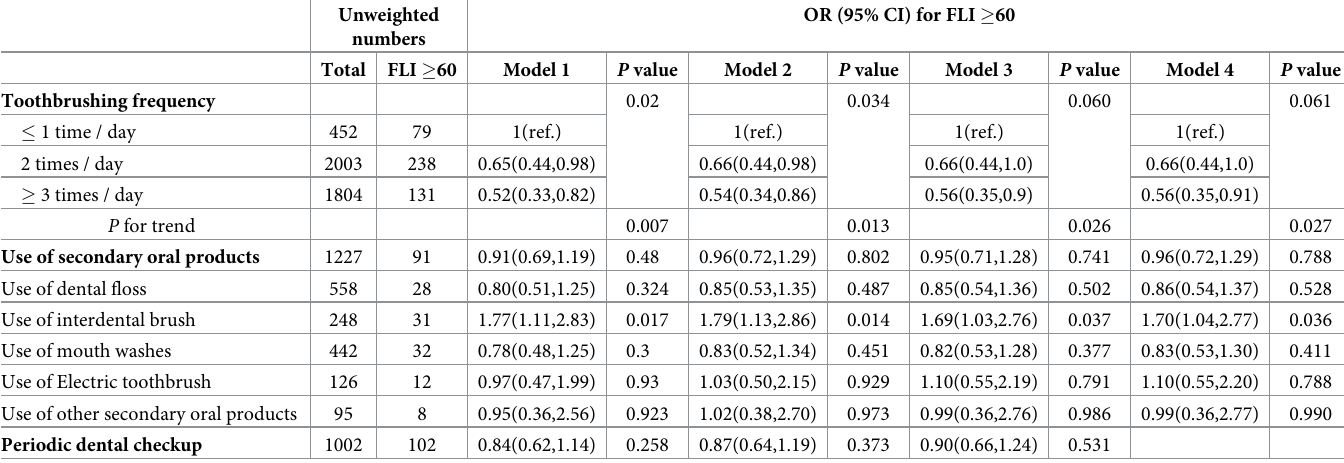
Table 2. Non-alcoholic fatty liver disease prevalence in multiple logistic regression models of oral hygiene